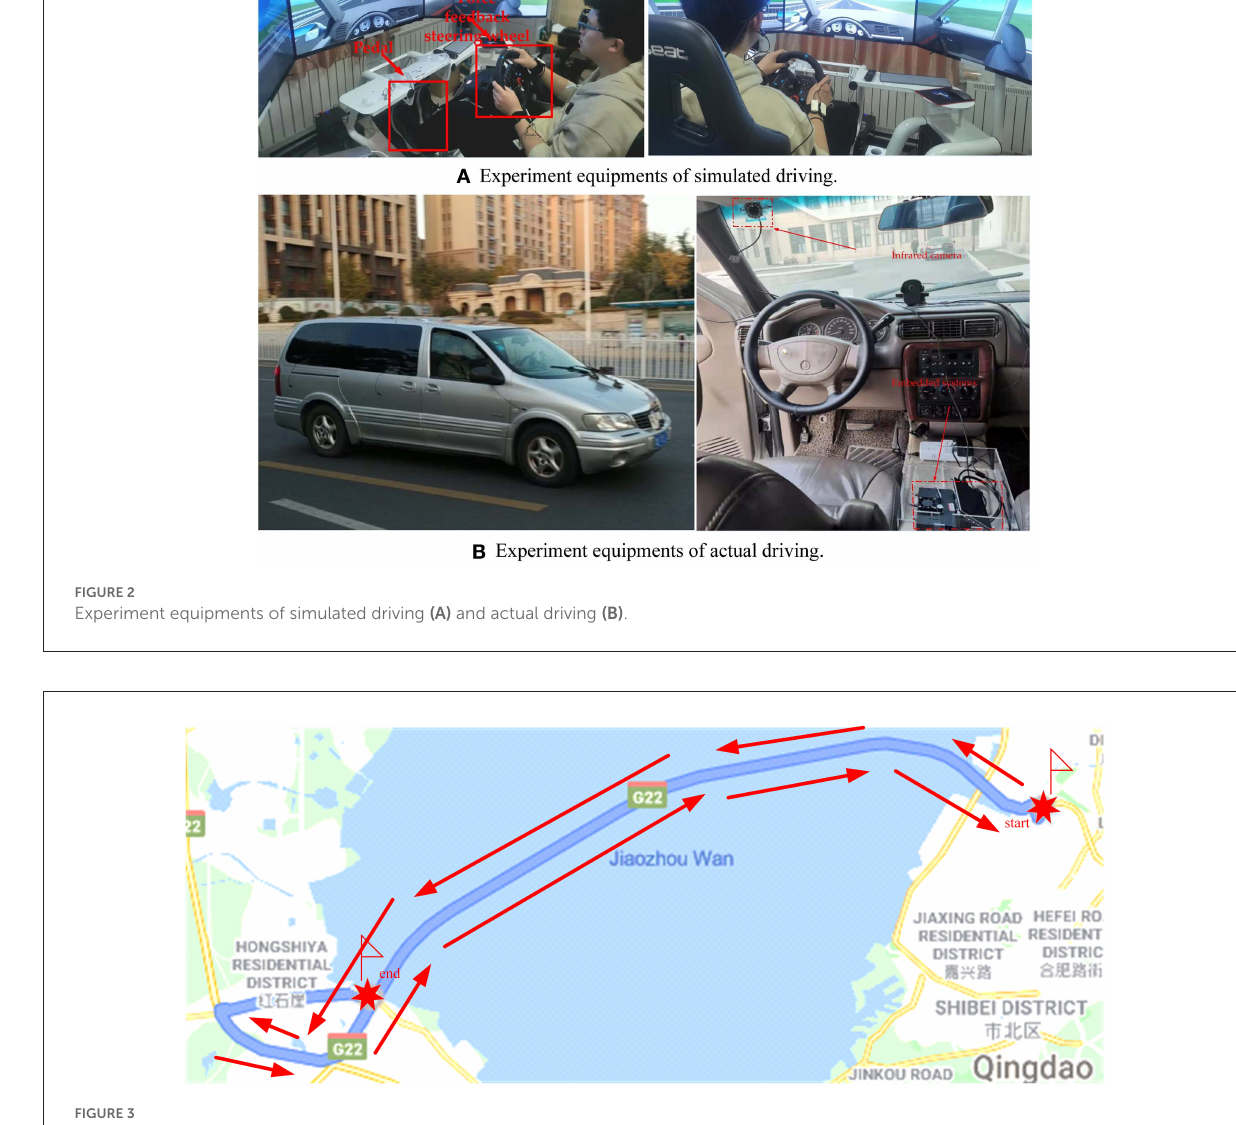
FIGURE3 Experiment route for actual